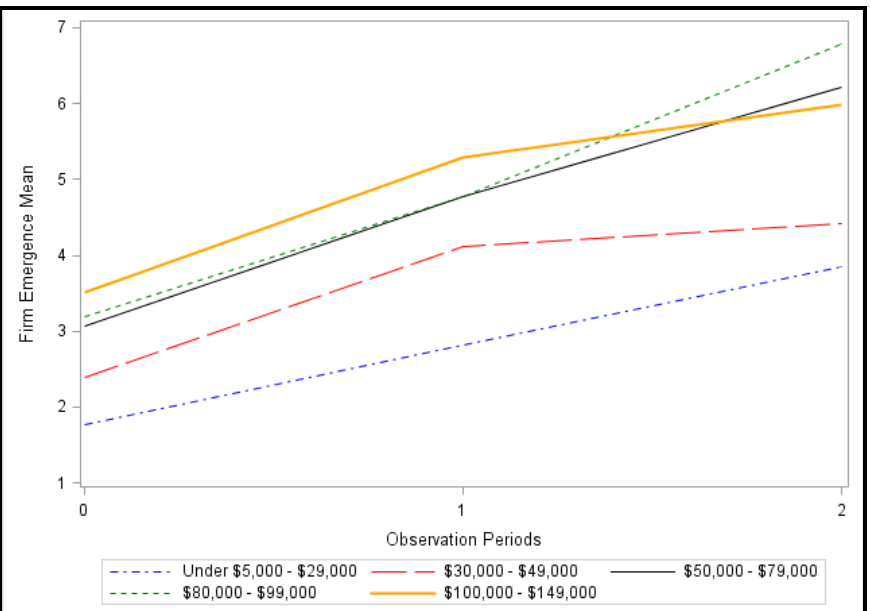
Figure 1. Average Firm Emergence by Household Income